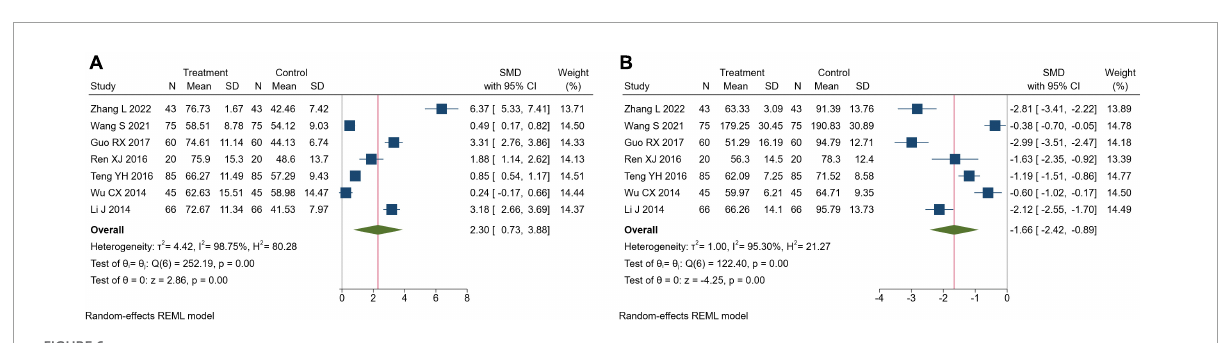
FIGURE6 Forest plot of endothelial function. (A) Nitric oxide; (B) endothelin.